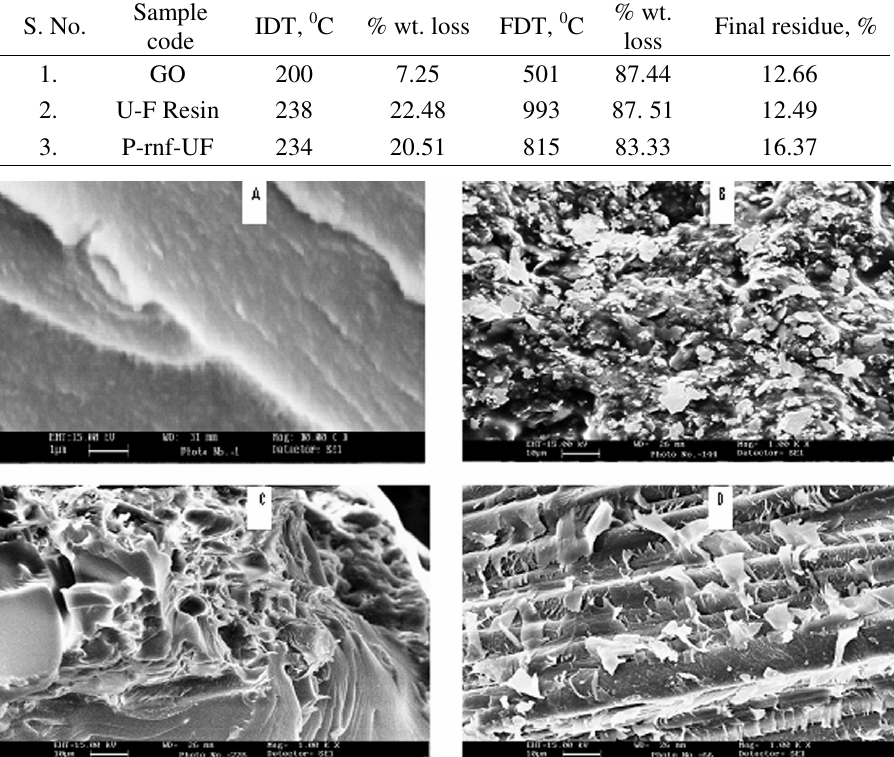
Figure 2. SEM images of UF resin (A) and Grewia optiva fiber reinforced polymer composites